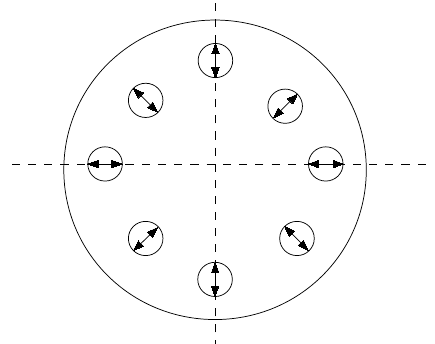
Figure.2. The maximum and minimum transmission directions of ultra-wide-angle telecentric optical lenses By combined the maximum and minimum transmission directions as the reference coordinate system, a Mueller matrix is constructed for the description of polarization sensitivity of optical components. Removed polarizers from the optical structure, define the Stokes vector as S’ k,a = [ I ’ k,a Q’ k,a U’ k,a ] (There is no V component in the l,p l,p l,p l,p vector because the SDPC does not detect the circular polarization). It reaches to the CCD detector array can be expressed as